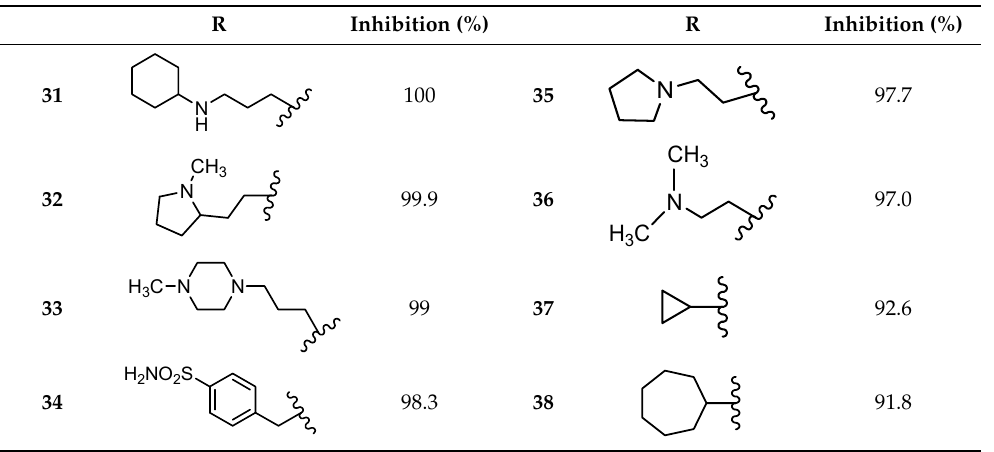
Table 2. Structural details and human cytomegalovirus (HCMV) polymerase inhibition values of compounds 21 – 30 (adapted from [86]). R